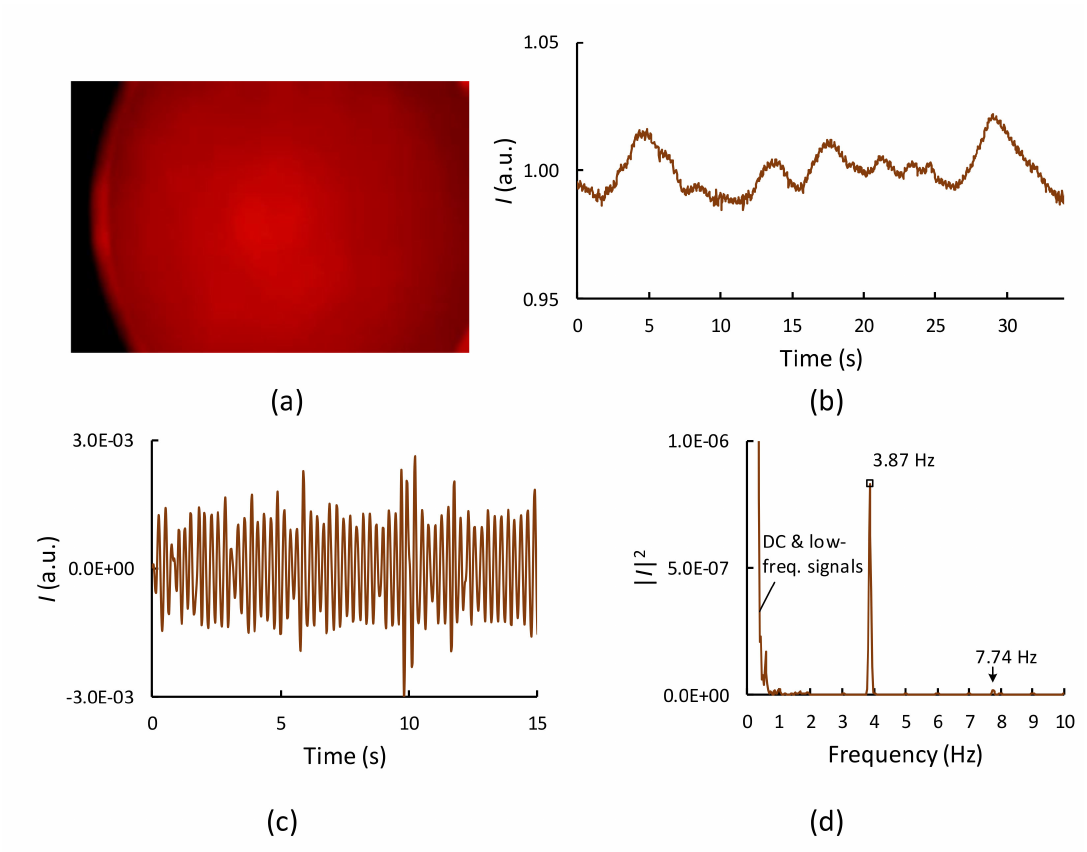
Figure 2. Embryonic heart rate extraction from a recorded video file. ( a ) Typical image acquired from a fertile egg using the smartphone setup, on day 13 of incubation. ( b ) Normalized photoplethysmography (PPG) signal extracted from the recorded video file. ( c ) Processed PPG waveform after the detrending and filtering methods were applied. ( d ) Corresponding power spectrum in the range 0–10 Hz (without applying bandpass